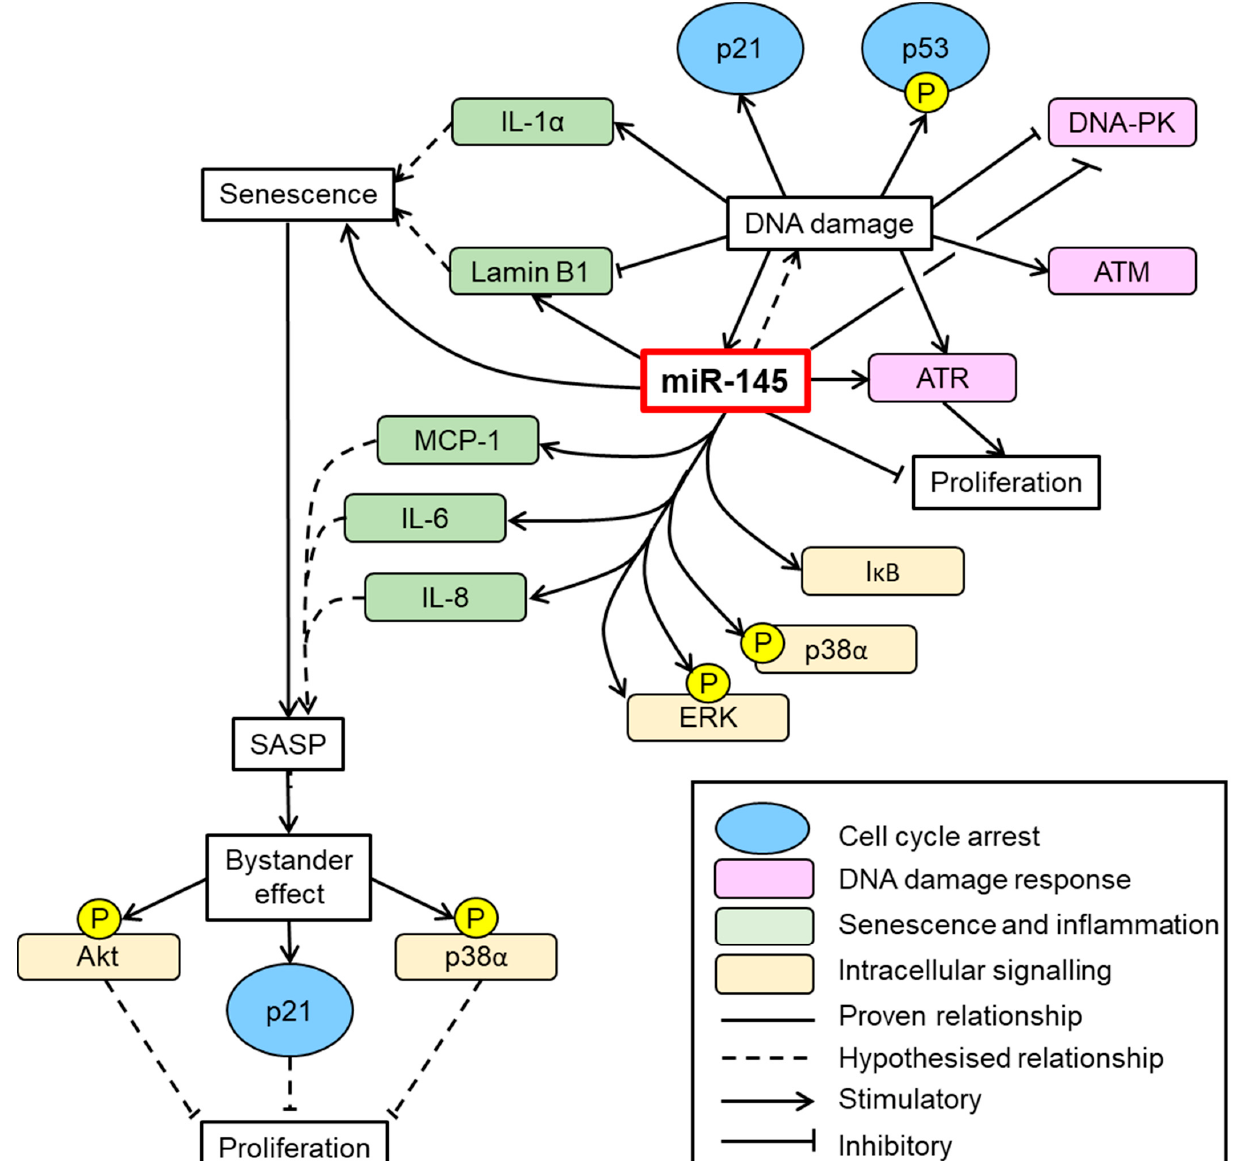
Figure 8. Summary of the central role for miRNA-145 in influencing SV-SMC DNA damage, proliferation and senescence. DNA damage upregulates expression of miRNA-145 in addition to inducing cell cycle arrest (p21 and p53 phosphorylation), upregulating apical kinase expression (ATR, ATM, DNA-PK) and cellular senescence (IL-1 α , Lamin B1 and SA β -gal. miRNA-145 reinforces DDR by also upregulating ATR expression, triggering intracellular kinase cascades (I κ B, p38 α , ERK) and inducing components of SASP (MCP-1, IL-6, IL-8). This induction of senescence and SASP inflicts a paracrine bystander effect on neighbouring cells through chronic activation of Akt and p38 α , which can block cellular proliferation and perpetuate the T2DM-SMC phenotype.